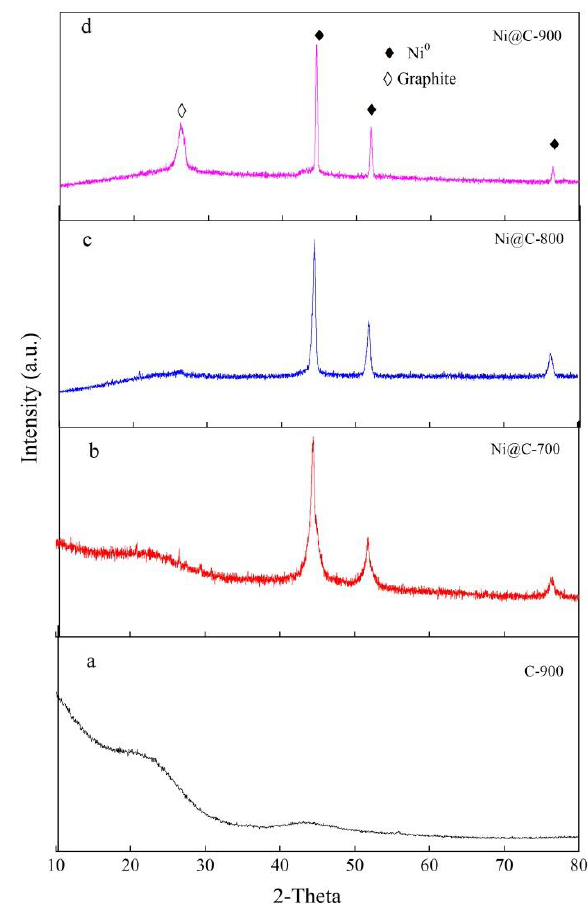
Figure 1. XRD patterns of ( a ) C-900 and the nanocatalysts ( b ) Ni@C-700, ( c ) Ni@C-800, and ( d ) Figure1. XRD patterns of ( a ) C-900and thenanocatalysts ( b ) Ni@C-700, ( c ) Ni@C-800, and ( d ) Ni@C-900.